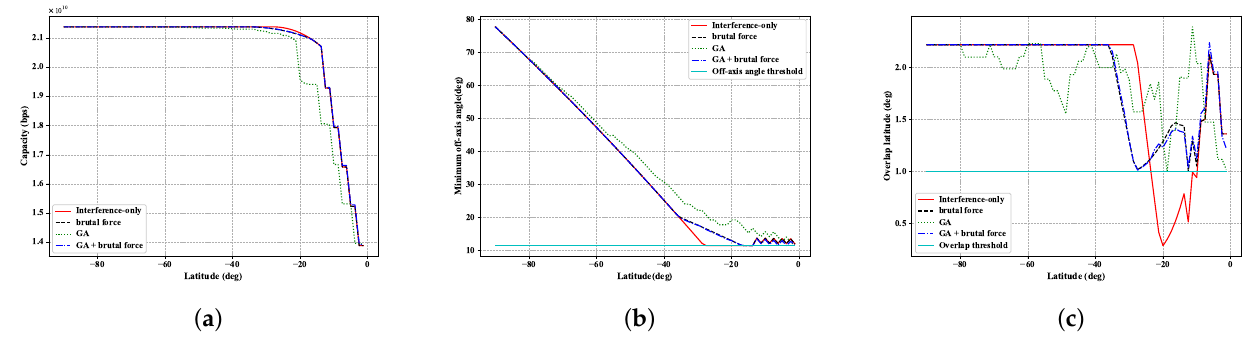
Figure 6. The comparisons of different schemes in terms of total capacity, minimum off-axis angle and coverage overlap: ( a ) total capacity of all active beams of the LEO satellite; ( b ) minimum off-axis angle in the minor axis of LEO satellite beams; ( c ) coverage overlap between adjacent LEO